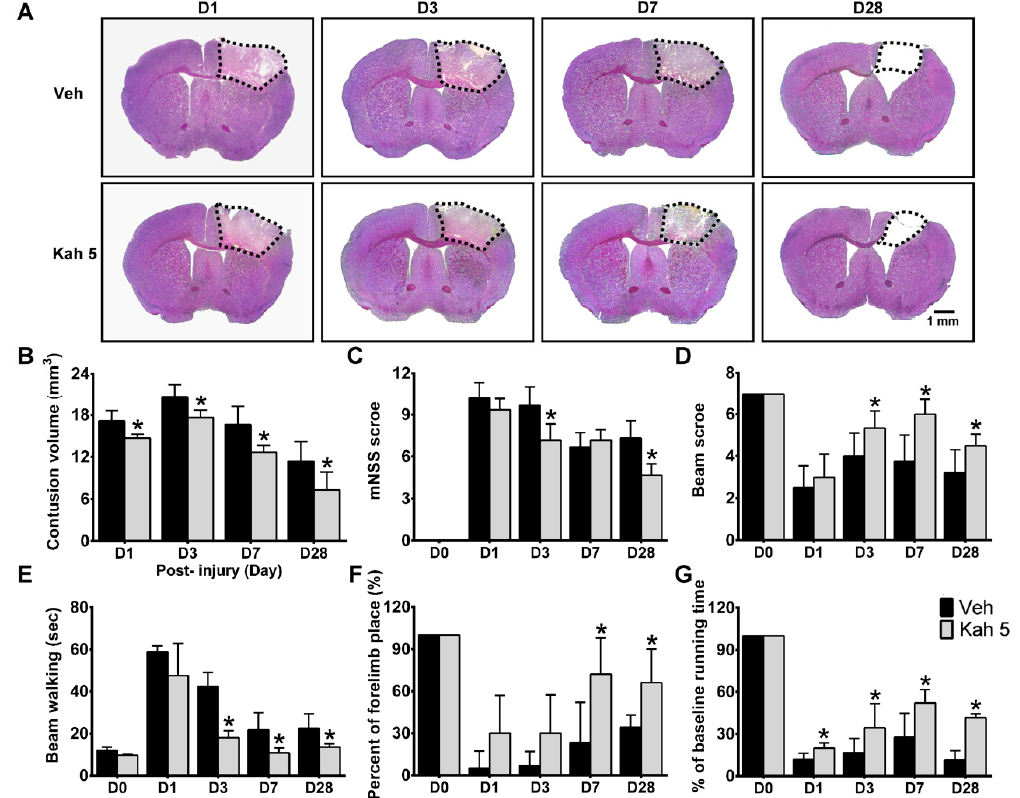
Figure 2. Single-dose kahweol treatment reduced long-term brain tissue loss and improved long-term neurobehavioral functions after TBI. ( A ) Representative cresyl violet-stained brain sections of Veh- and Kah 5-treated TBI animals at days 1, 3, 7, and 28 post-injury. Dotted area indicates the contusion region that lacks staining in the ipsilateral cortex. Scale bar = 1 mm. ( B ) Kah 5 treatment significantly reduced contusion volume from days 1 to 28 after TBI. n = 6 to 10 for Veh and Kah 5 groups. * p < 0.05 versus Veh group. When compared with the Veh group, Kah 5-treated animals showed significantly reduced ( C ) modified neurological severity score (mNSS) on days 3 and 28 post-TBI, better ( D ) beam score, and reduced ( E ) beam walk latencies from days 3 to 28 post-injury, improved ( F ) forelimb